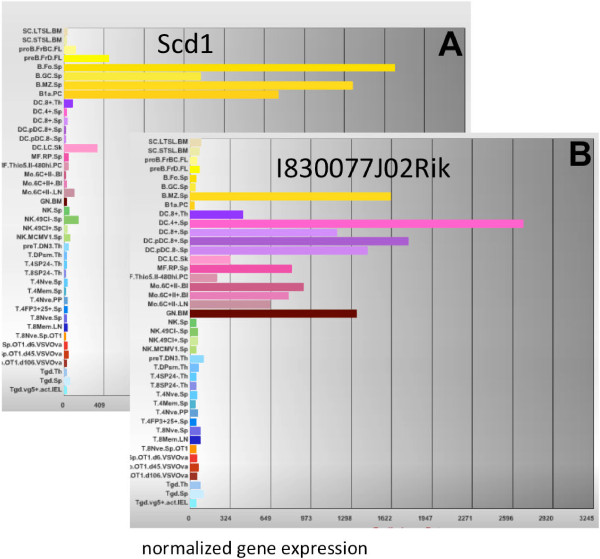
Global expression of candidate cell marker genes. A) Expression of Scd1, as represented for key immune cell populations at the Immunological Genome resource. B cells subtypes are labelled in yellow. B). Expression of I830077J02Rik. The yellow peak is marginal zone B cell. All of the myeloid cells types also express high levels of this gene.